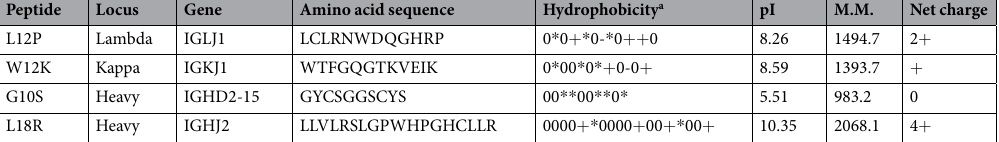
Table 1. Characteristics of the selected peptides encoded by immunoglobulin genes. a 0: hydrophobic, * polar, + , and − : positively charged and negatively charged residues; pI: isoelectric point; M.M.: molecular mass (Daltons).